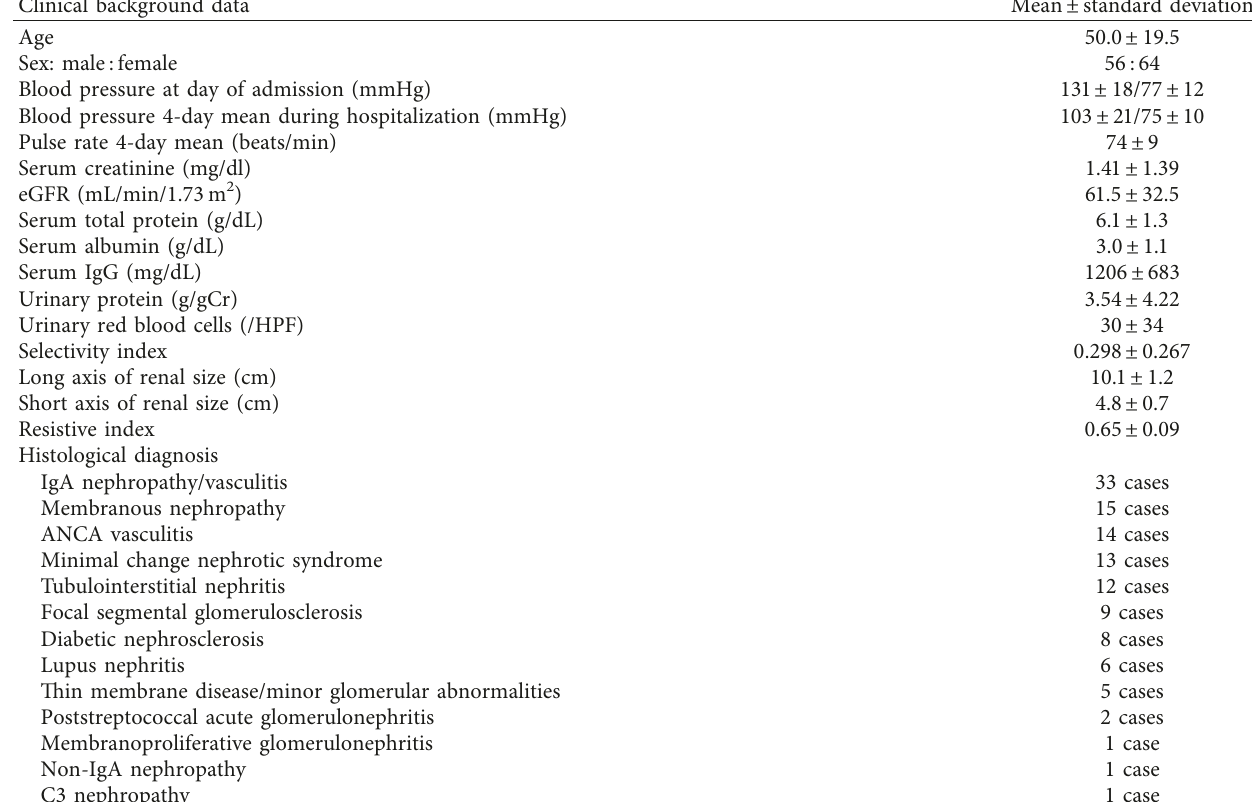
Table 1: Clinical data at the time of renal